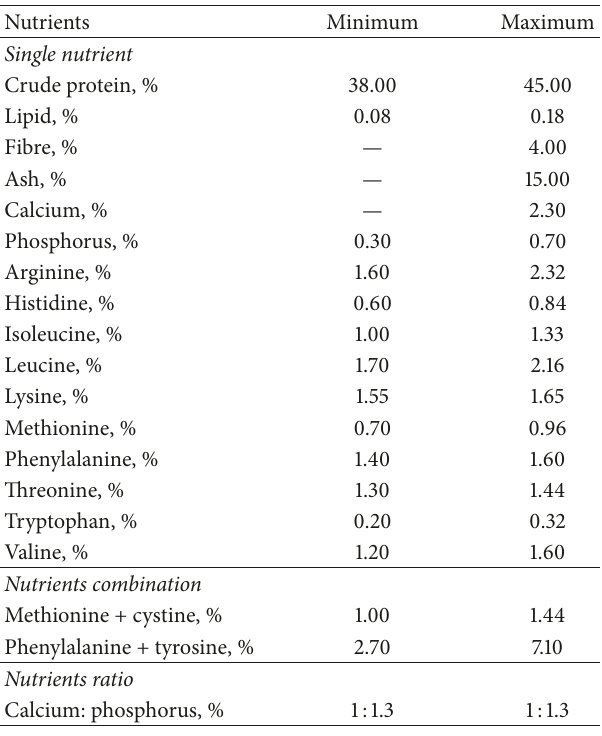
Table 3: A list of nutrients and its specific